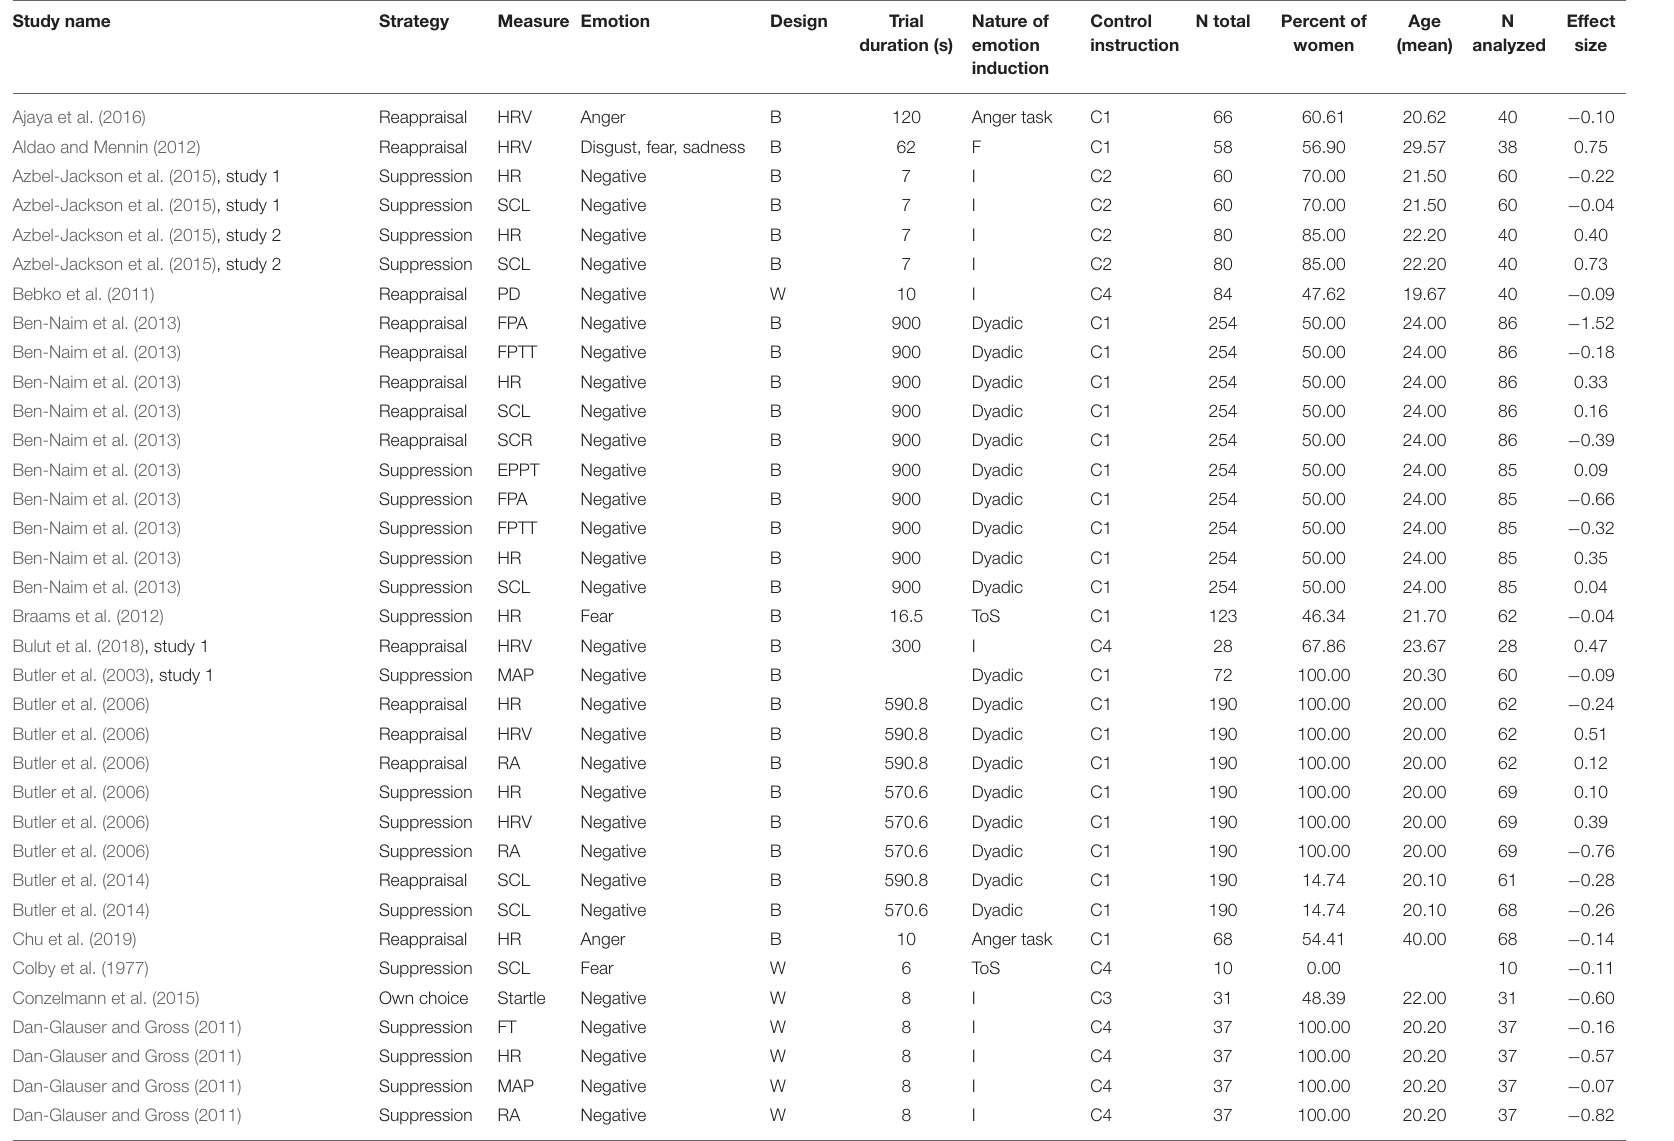
TABLE 3 | Characteristics and effect sizes for studies included in the